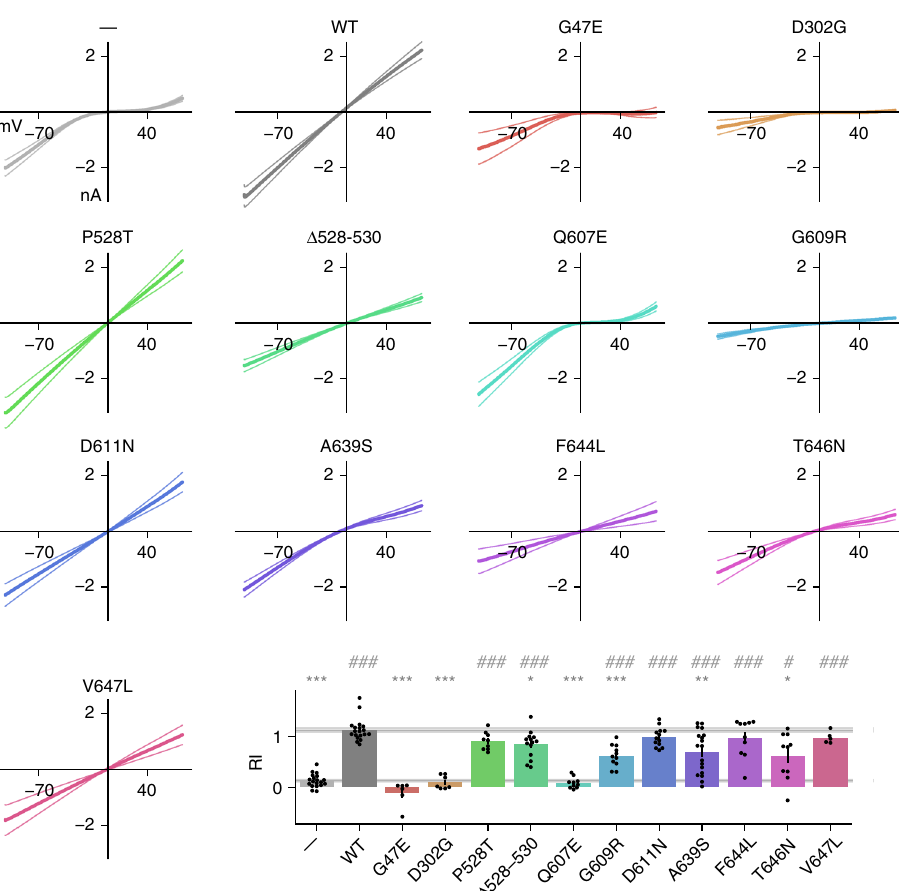
Fig. 6 Recti fi cation of GluA2 mutants when co-expressed with GluA1. Voltage was ramped from − 104 mV to + 76 in order to assess recti fi cation of KA- evoked currents. Ramp currents recorded in the absence of KA were subtracted from ramp currents in 1 mM KA. Controls showed linear current – voltage (I – V) relations for cells co-expressing GluA1 and GluA2 WT, and clear recti fi cation in cells transfected with GluA2 alone. The panels show average ramps ±SEM for each mutant ( n ≥ 6 cells per mutant). Recti fi cation index (RI) was quanti fi ed as ( I + 40 / I − 70 ) *( − 7/4). RI was compared to WT (* p < 0.05, ** p < 0.01, *** p < 0.001) and GluA1-negative control (# p < 0.05, ## p < 0.01, ### p < 0.001). Data are averaged from the following numbers of cells per mutant: —